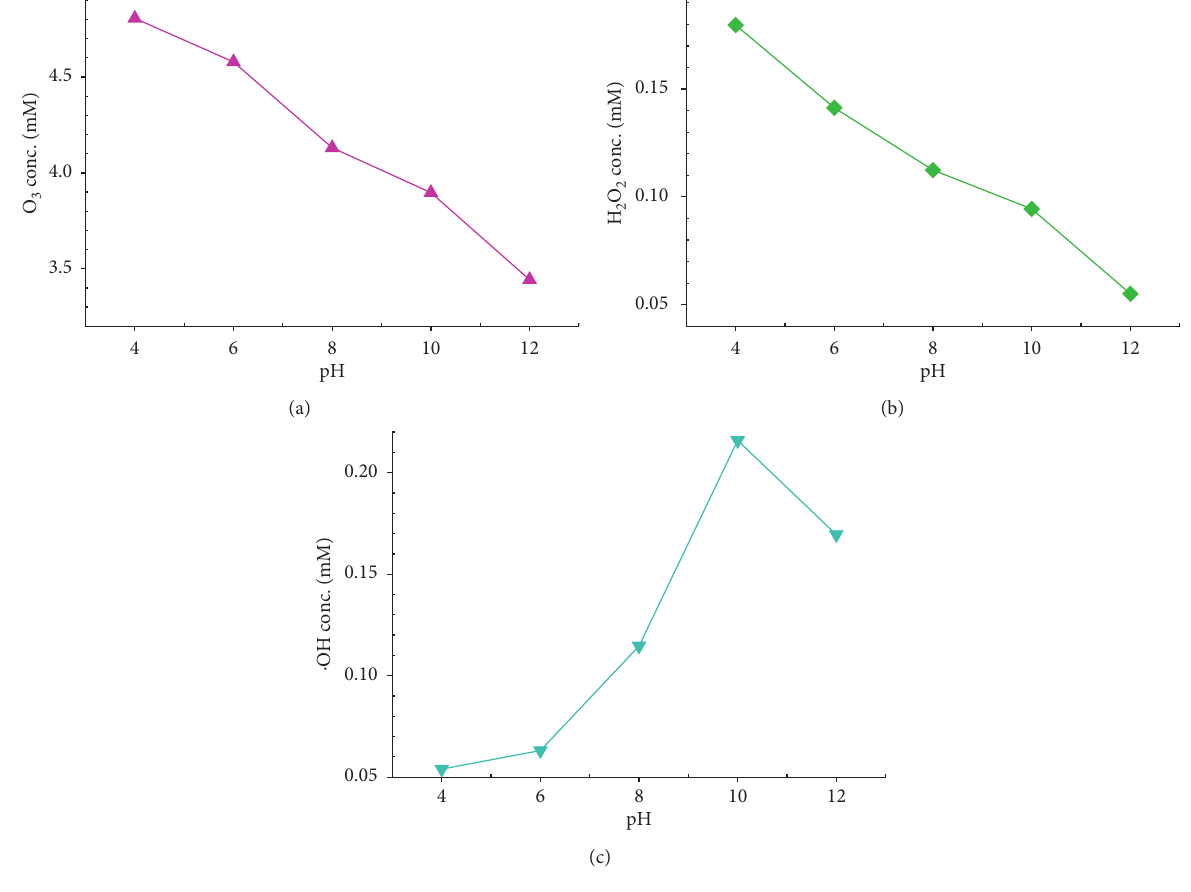
Figure 6: Effect of pH on the formation of (a) O